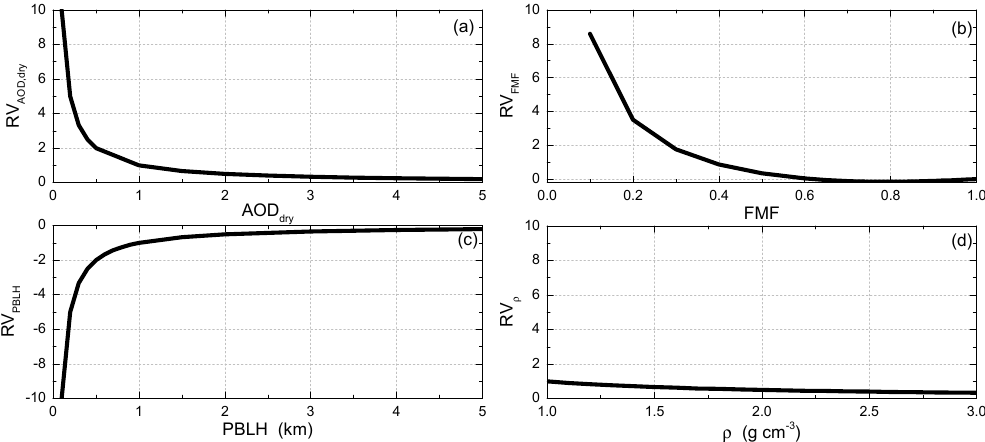
Figure A1. The changes of relative variability (RV) as a function of typical ranges of key factors (( a ) AOD dry , ( b ) FMF, ( c ) PBLH, ( d ) ρ f,dry ) in the PMRS model.